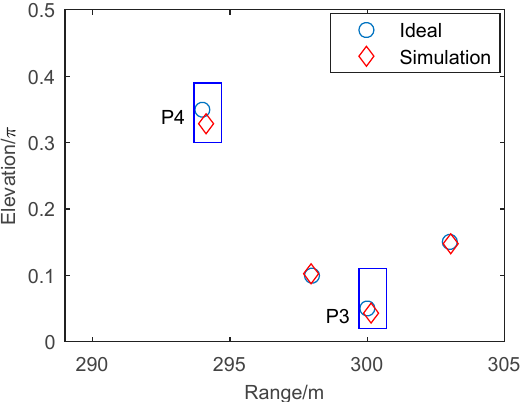
Figure 7. The 2-D imaging result of range-azimuth in the bistatic geometry. ( a ) The result of TR1; ( b ) the result of TR2. According to the 2-D imaging result of TR1 and TR2, the real range r and the elevation θ of the target can be solved by utilizing (14)–(17). The ideal imaging and the simulation imaging by the proposed method are shown in Figure 8. The red points represent the ideal imaging, and the blue points represent the simulation results, respectively.